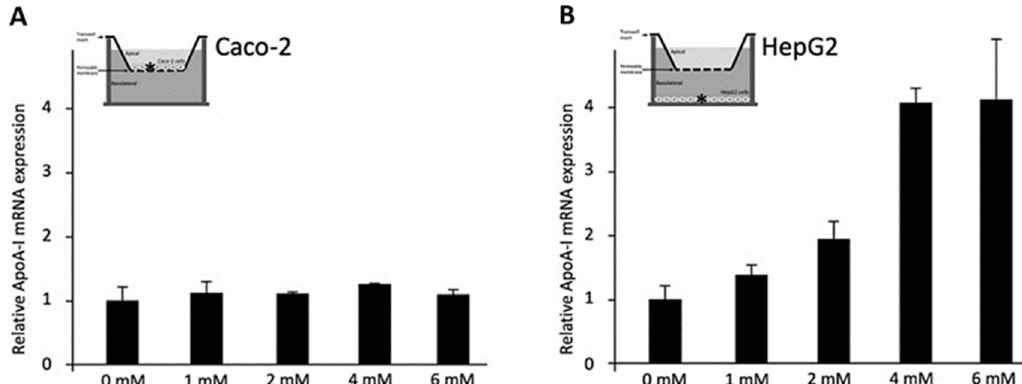
Figure 3. Relative Apolipoprotein A-I (ApoA-I) mRNA expressions in Caco-2 and HepG2 cells treated with different concentrations of C4. ( A ) Increasing C4 concentrations did not have any significant effects on ApoA-I mRNA expression in Caco-2 cells. ( B ) Increasing C4 concentrations showed a significant increase in ApoA-I mRNA expression in HepG2 cells ( p < 0.001). All results are presented as the mean, while error bars indicate standard deviations. Data were normalized against the expression observed in the control condition, which was arbitrarily set at 1. A linear regression was performed for C4 dose-response effects. Changes were considered significant when the regression coefficients were significantly different from zero ( p < 0.05). ApoA-I, apolipoprotein-I; mRNA, messenger RNA.